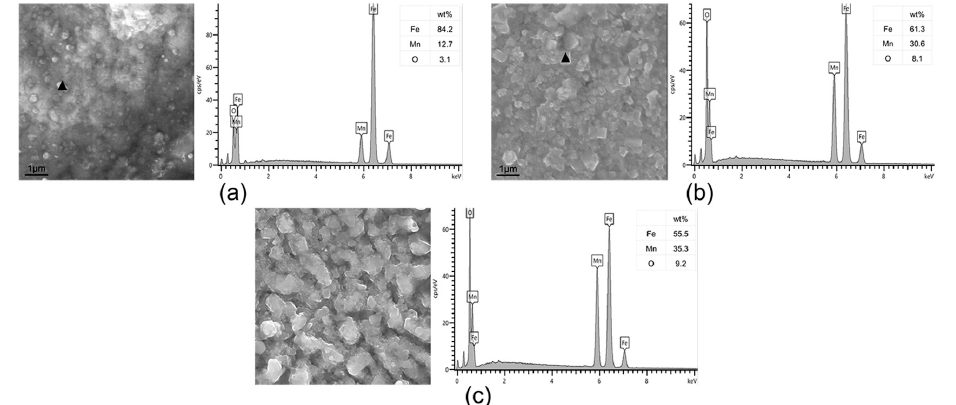
Figure 5. SEM micrographs and EDS analyses of surface oxides on the steel surface of samples annealed at different dew points. ( a ) 4# ( − 50 °C), ( b ) 5# ( − 10 °C), ( c ) 6# (+10 °C).